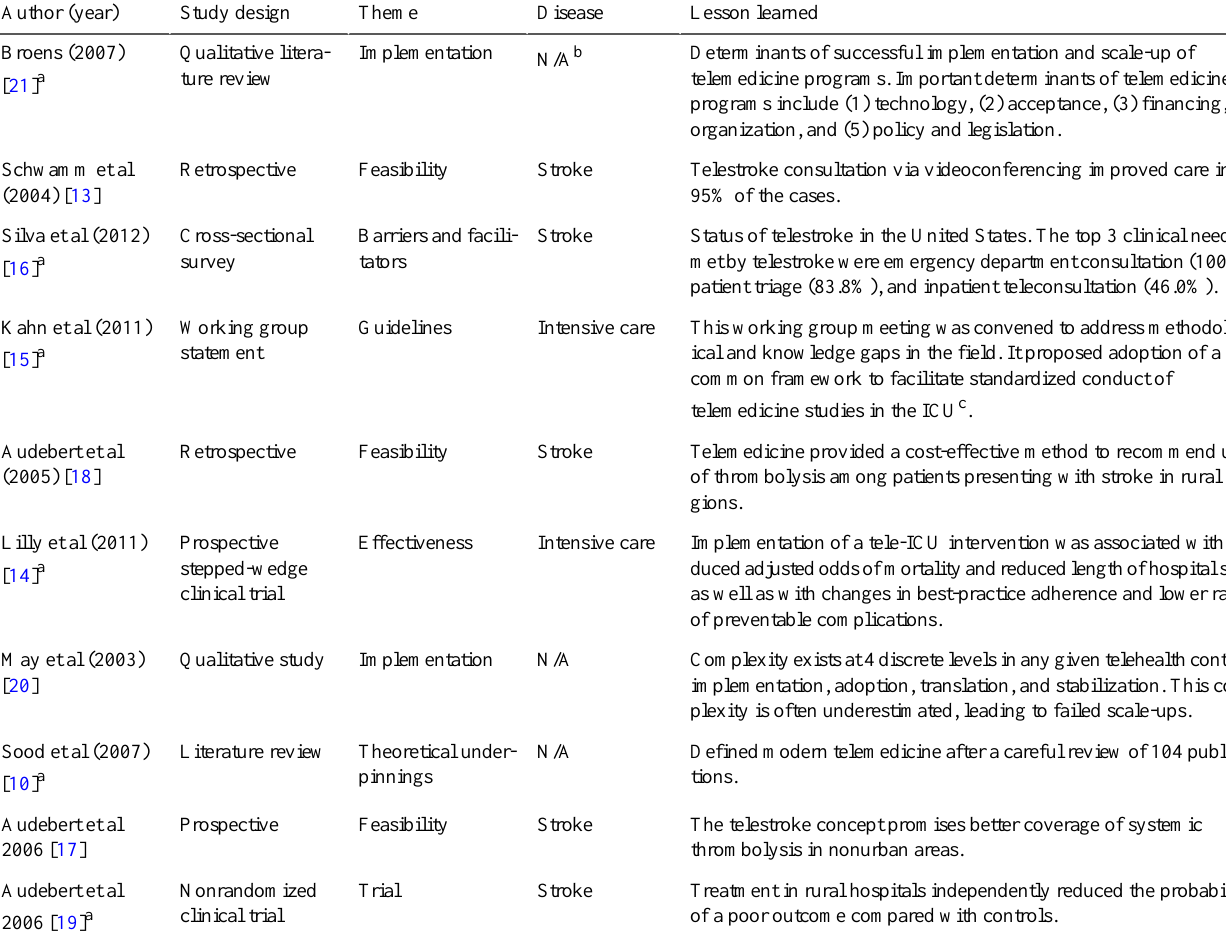
Table 2. Lessons learned from landmark publications from 2009 to